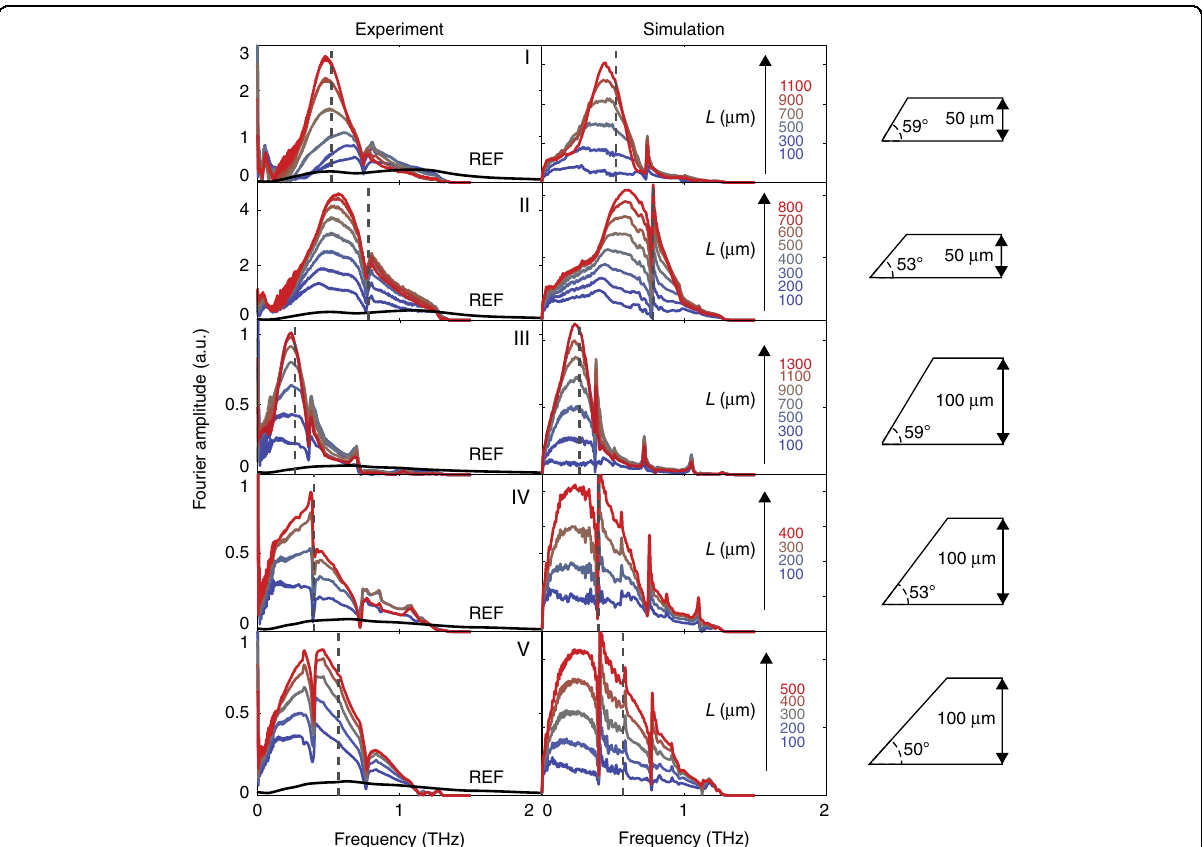
Fig. 3 Buildup of THz spectral amplitude from both experiment and simulation at room temperature. The corresponding sample for each row of plots is shown on the right. The theoretical buildup frequency is marked by the vertical grey dotted line in each plot. The legend for each plot gives the selected buildup distances, L , from L = 100 μ m to L ≈ L